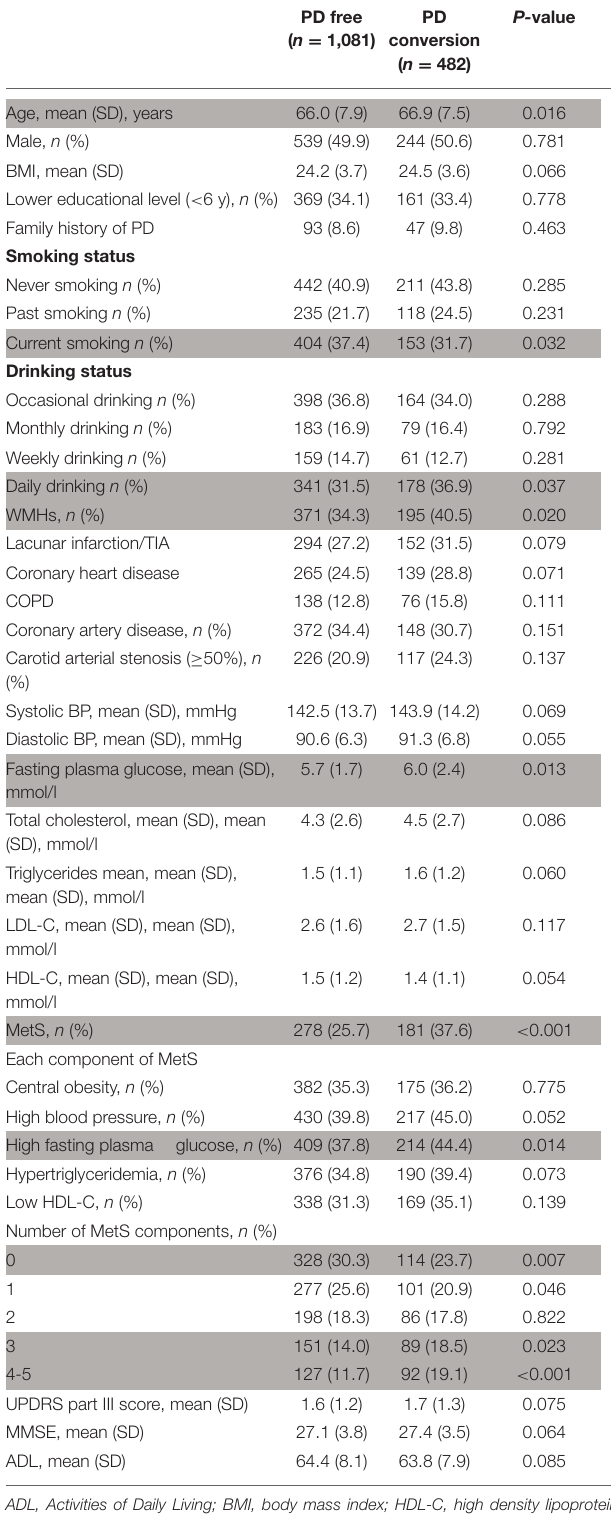
TABLE 1 | Baseline characteristics of participants with PD